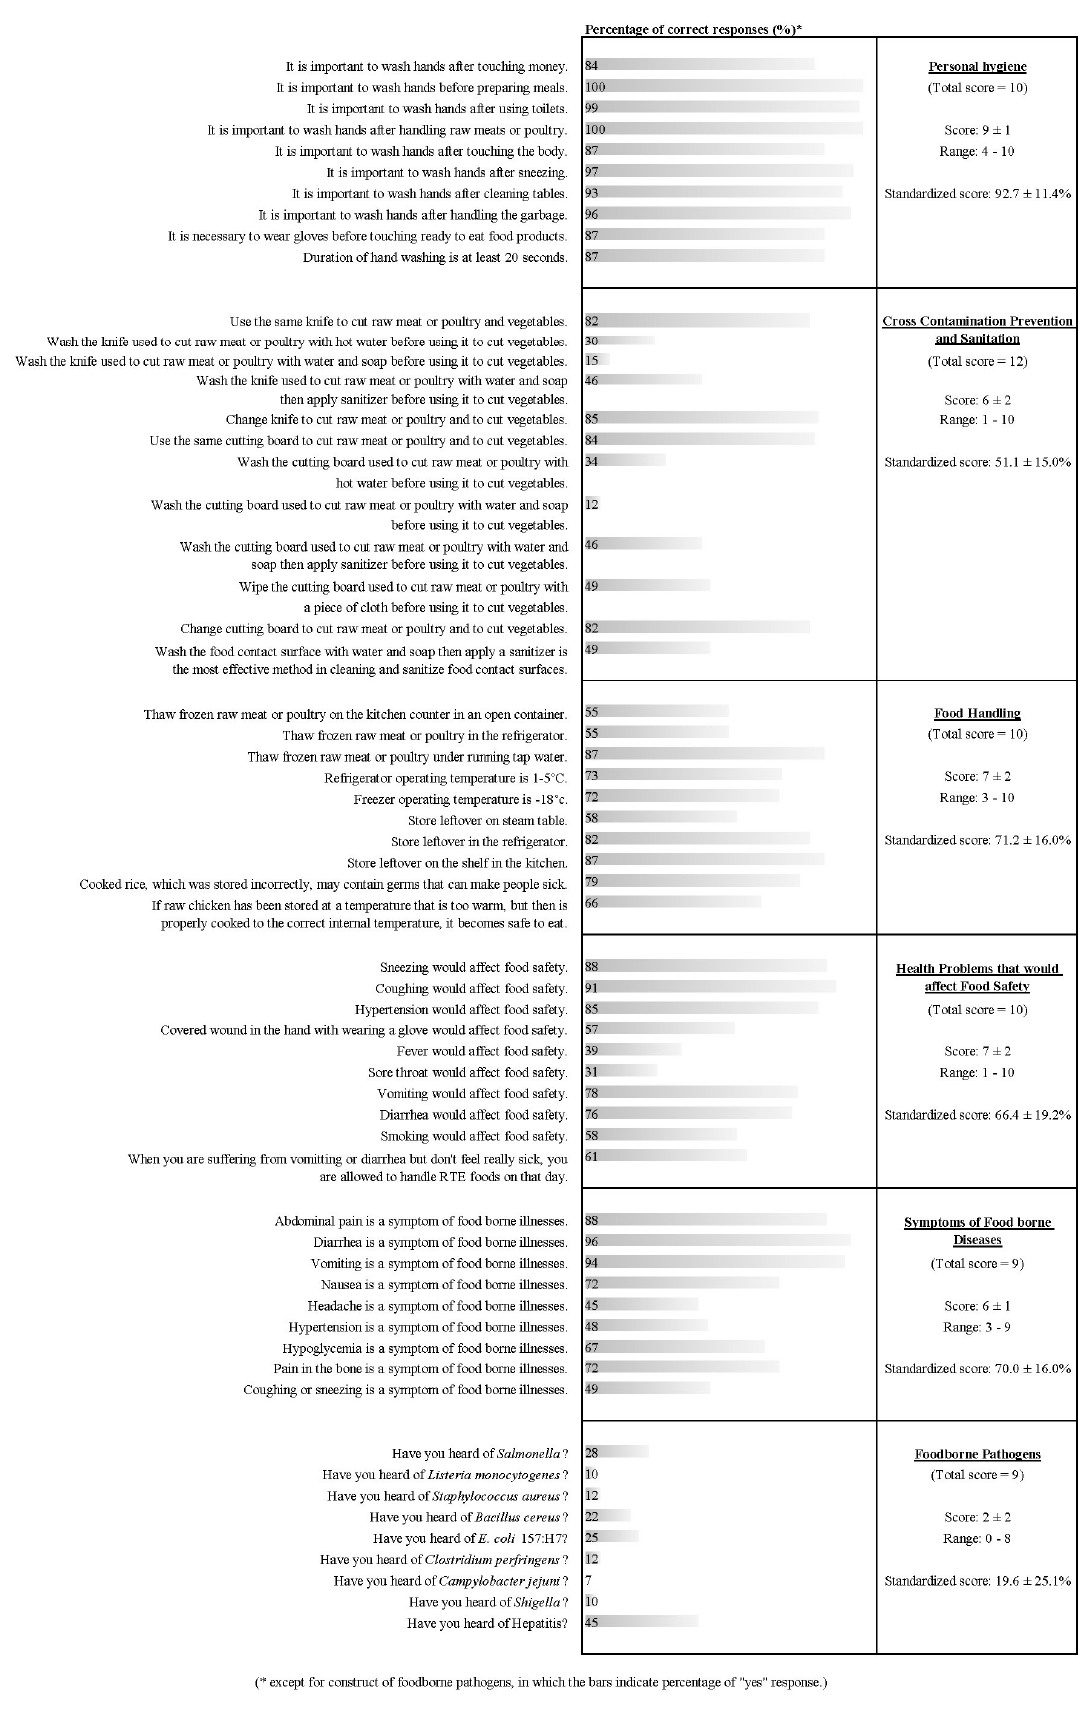
Figure 1. Percentage of the correct answers on food safety knowledge scored by 67 food handlers.